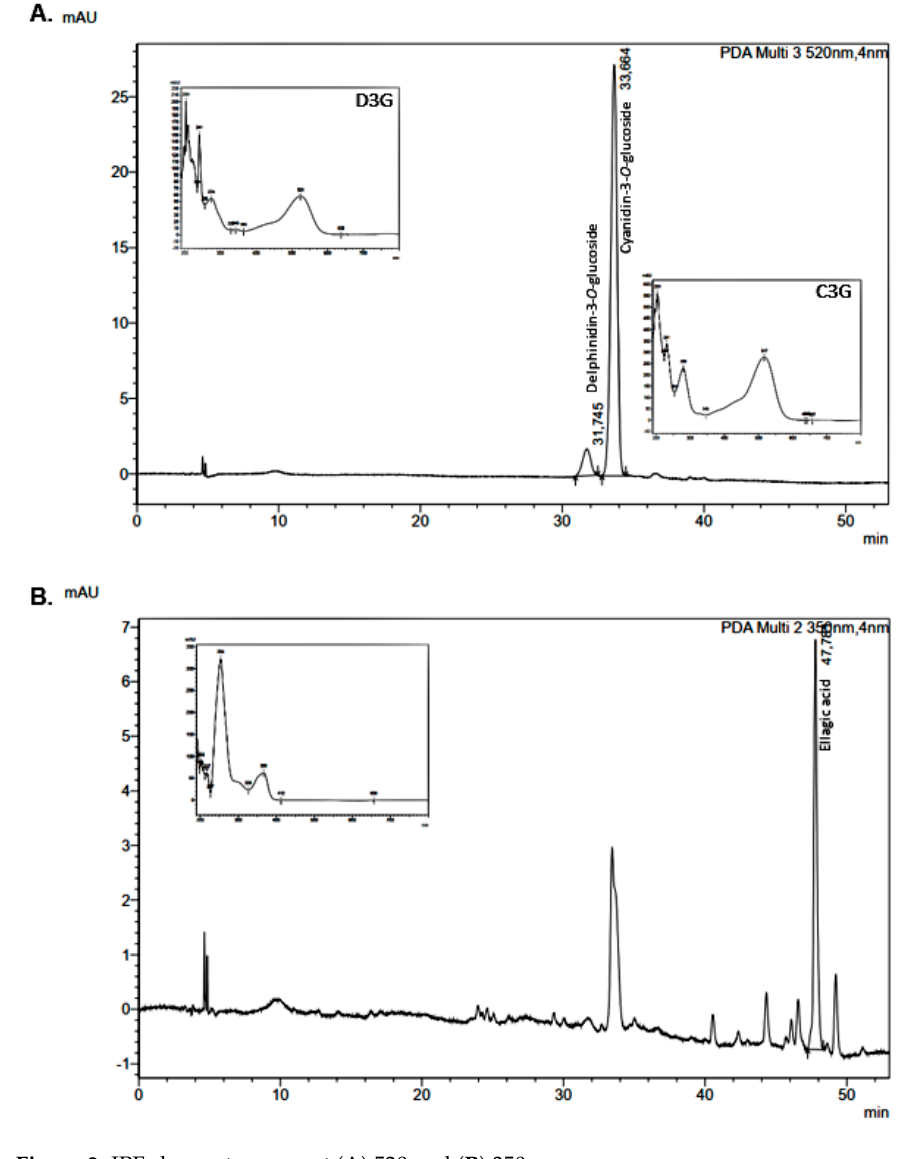
Figure 2. JPF chromatograms at ( A ) 520 and ( B ) 350 nm.